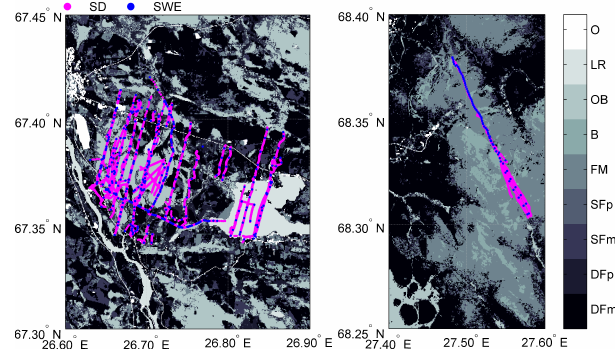
Figure 1. Snow depth (pink) and SWE (blue) measurements col- lected at the Sodankylä (left) and the Saariselkä (right) test sites during the SnowSAR-2